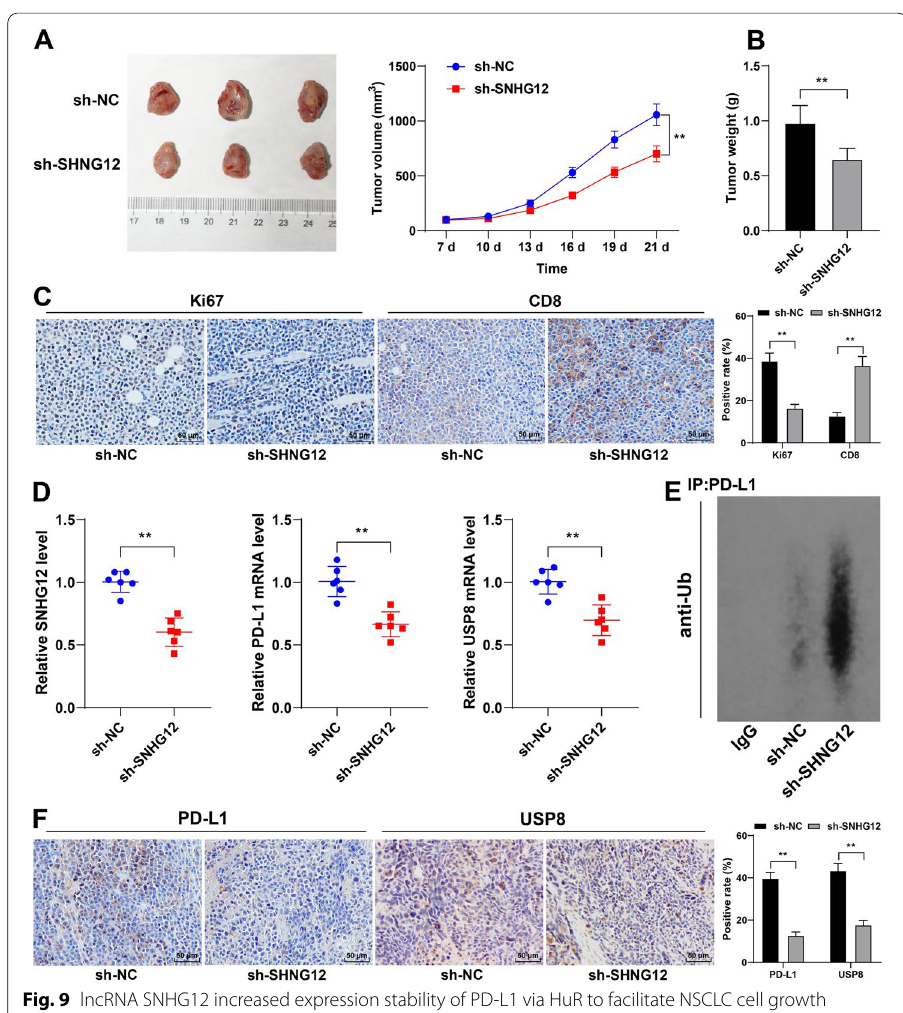
Fig. 9 lncRNA SNHG12 increased expression stability of PD-L1 via HuR to facilitate NSCLC cell growth and immune escape in vivo. A , B Volume and weight of representative xenograft tumors; C positive rates of Ki67 and CD8 were determined via immunohistochemistry; D SNHG12, PD-L1, and USP8 expression was measured via western blotting; D SNHG12, PD-L1, and USP8 levels were determined via RT-qPCR; E ubiquitination level of PD-L1 in xenograft tumors was determined via Western blot analysis; F positive rates of PD-L1 and USP8 were determined via immunochemistry. ** P < 0.01. Data are represented as mean standard deviation. Pairwise comparisons in B and D were analyzed using t -test, and multi-group ± comparisons in A , C , and F were analyzed using two-way ANOVA, followed by Tukey’s multiple comparison